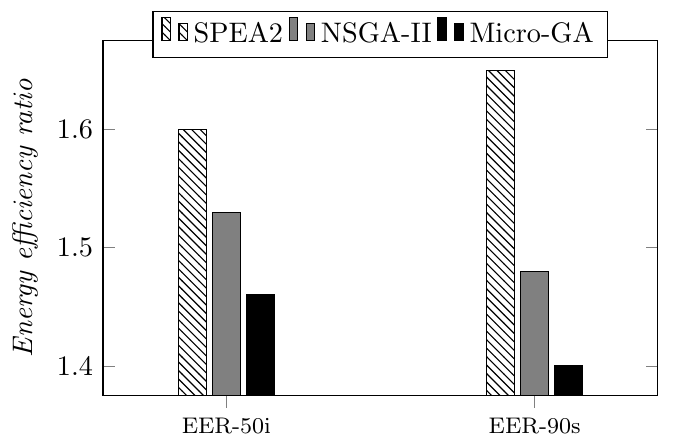
Figure 11. Comparison of energy efficiency ratio achieved by the best solutions for both stopping criteria as obtained by the applied